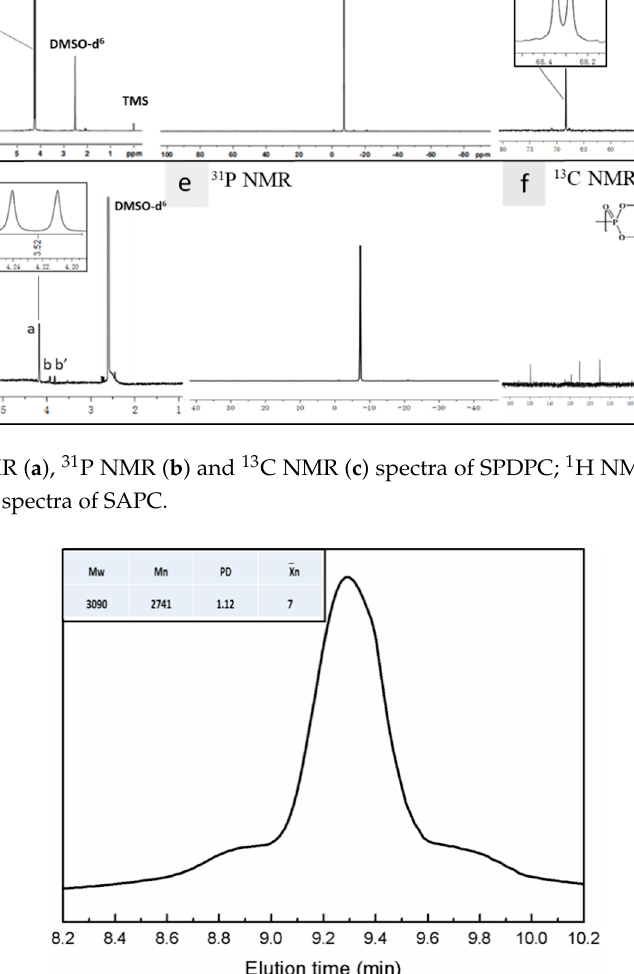
Figure 3. Gel permeation chromatography (GPC) curve of SAPC.